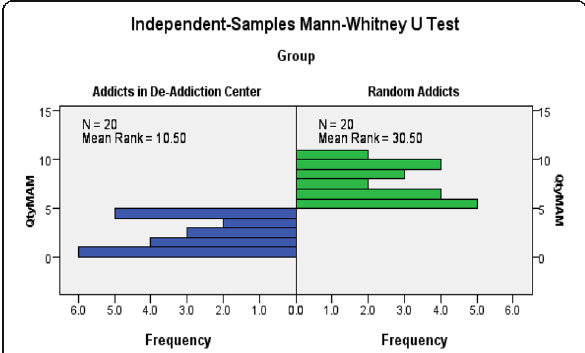
Fig. 4 Mann – Whitney U statistics, frequency distribution for 6-MAM concentration in random heroin addicts ’ group and addicts going through rehabilitation at the de-addiction center group. There is a significant difference between mean rank for addicts undergoing rehabilitation compared to random regular addicts for 6-MAM levels in the hair